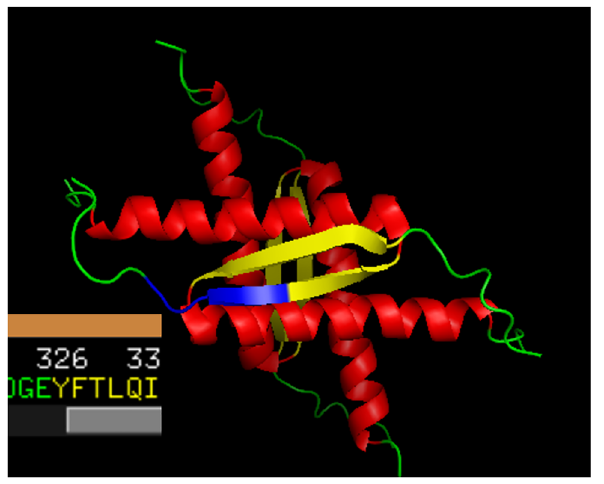
Figure 2: PDB entry 1OLG, depicted with PyMol. Yellow color denotes 𝛽 -sheets. The GEYFT prefix, where GE are green (it is not a part of the parallel 𝛽 -sheet) and YFT are yellow (i.e., YFT are the first three residues of the parallel 𝛽 -segment), is emphasized at the left middle section of thefigure,whileitscorrespondingsequenceatthelower left corner.